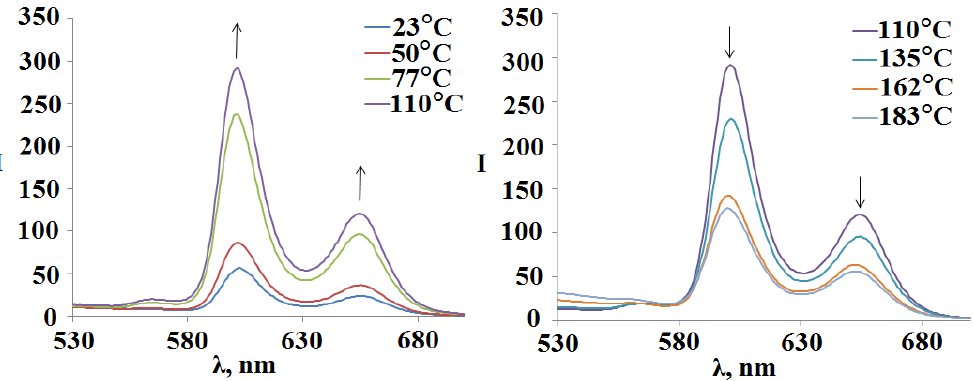
Figure 11. Change in the fluorescence spectra of the compound 3 (Sn(L)2P)4(PdCl 2 )4 when the temperature of the DMSO solution varies from 23 °Cto183 °C.